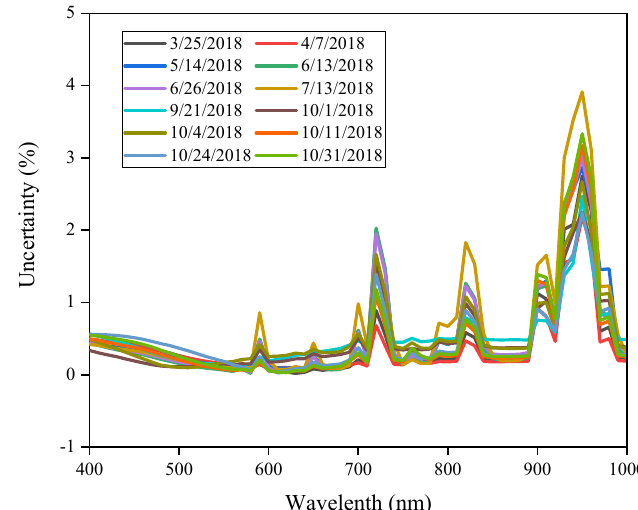
Figure 14. Combined uncertainty of the predicted TOA reflectance caused by atmospheric parameters on the study dates. Table 5. Combined uncertainty of the predicted TOA reflectance caused by atmospheric parameters in bands 2, 3, 4, and 8 of Sentinel-2B/MSI.